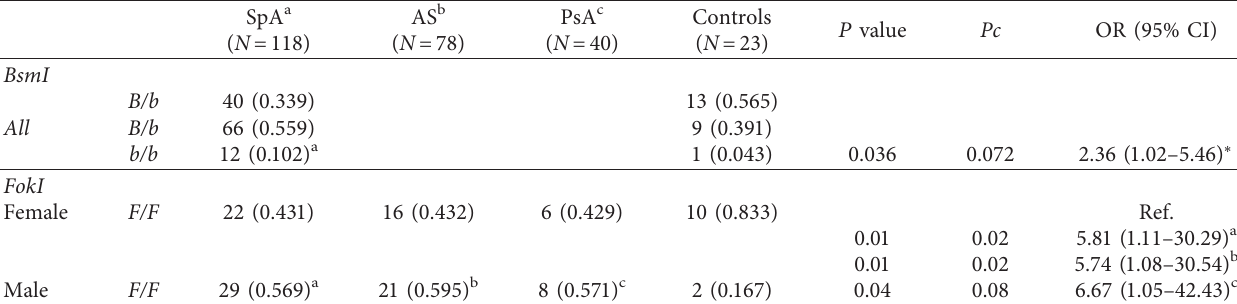
Table 6: Association between Fok I and Bsm I with spondyloarthritis (SpA), ankylosing spondylitis (AS), and psoriatic arthritis (PsA) considering covariates gender and vitamin